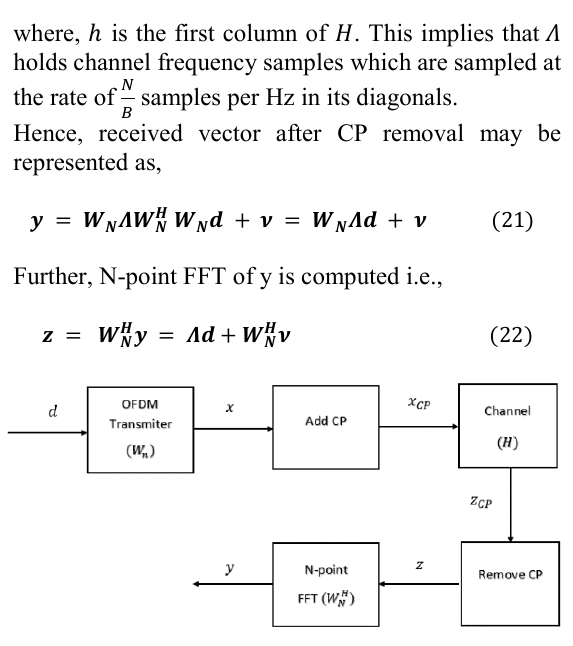
Figure 2: OFDM modulation scheme.